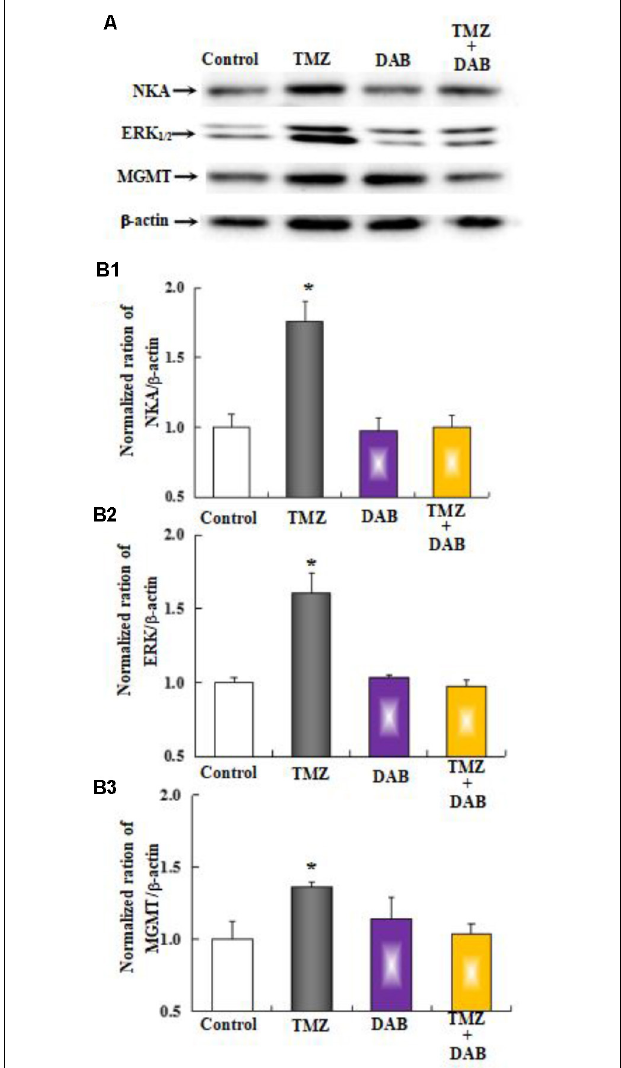
FIGURE 9 | The upregulation of TMZ-induced Na,K-ATPase, ERK 1 / 2 , and MGMT expression requires glycogenolysis in U251 cells. (A) Cells were incubated for 48 h in the absence of any drug (Control) or in the presence of 5 µ M TMZ. In some experiments, 10 mM DAB, an inhibitor of glycogenolysis, was added 4 h before the addition of TMZ. (B1) Mean Akt expression was quantified as ratios between Akt and β -actin. (B2) Mean ERK 1 / 2 expression was quantified as ratios between ERK 1 / 2 and β -actin. (B3) Mean MGMT expression was quantified as ratios between MGMT and β -actin. Similar results were obtained from three independent experiments. SEM values are indicated by vertical bars. ∗ Indicates a statistically significant ( P < 0.05) difference from the negative control